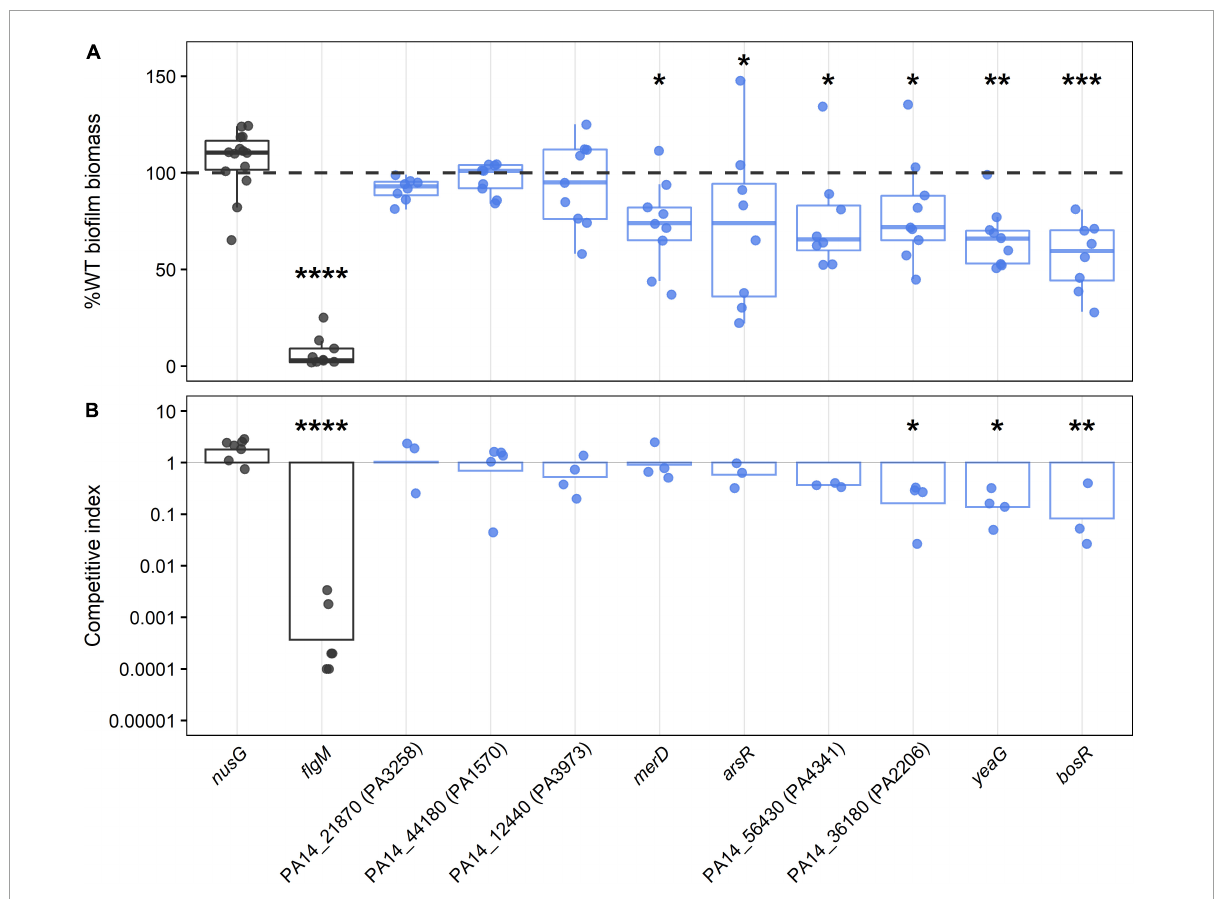
FIGURE3 Biofilm phenotypes of mutants with transposon insertions in regulatory genes required for growth in biofilms as determined by TnSeq. Control strains with WT-like biofilm level and known biofilm defect ( nusG and f lgM, respectively) are depicted in dark gray, and transposon mutants of biofilm gene candidates are colored in blue, with each circle representing an independent biological observation. (A) The box-whisker plot shows the medians of total biofilm biomass at 24 h normalized to WT levels and expressed as percentages. The dashed line is shown as a visual reference indicating 100% WT biofilm level. Statistical significance was determined using a Kruskal-Wallis test followed by Dunn post hoc test with the Benjamin-Hochberg p -value correction for multiple comparisons (* p < 0.05, ** p < 0.001, *** p < 0.0001, **** p ∼= 0). (B) Results of the competition assays between transposon mutants and WT in 96 h biofilm are shown as geometric means of competitive indices in the bar plot. ANOVA followed by Tukey’s HSD post hoc test were used to determine significance (* p < 0.05, ** p < 0.001, **** p ∼= 0).